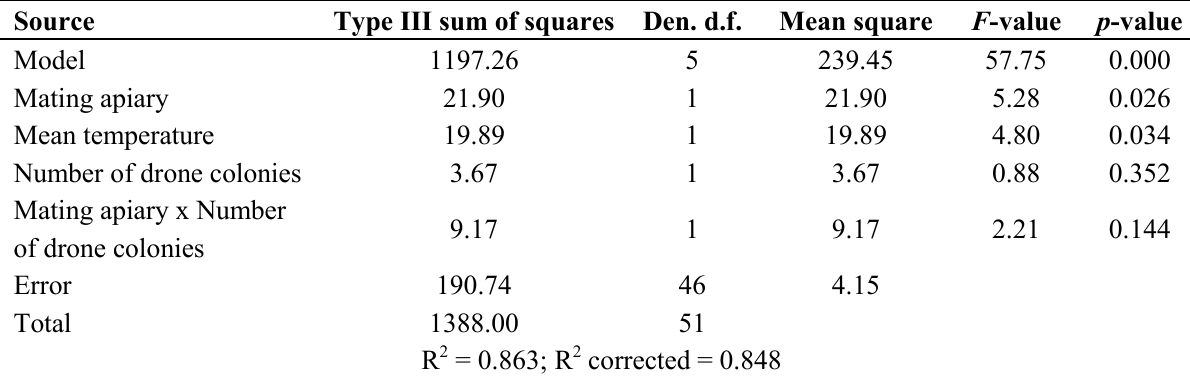
Table 4. Effects of mating apiary, mean temperature (included as a covariate) and number of drone colonies on the total number of nuptial flights of the queens on the first three flying days. Type III sum of squares, denominator degrees of freedom (Den. d.f.), mean square, F -value and p -value are given for each factor.